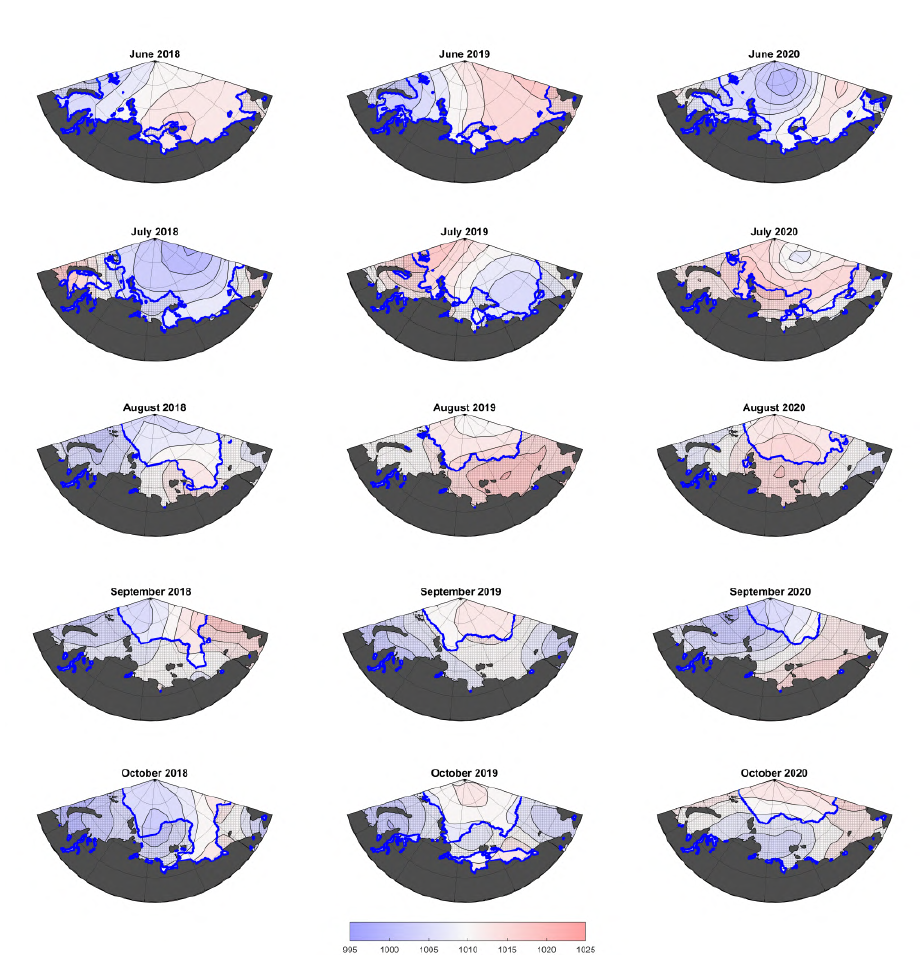
Figure 12. Ice edge position from June to October 2018–2020 from [12] (bold blue lines) and the corresponding NCEP/NCAR sea level pressure (hPa) distribution [42] (colors are according to colobar, extra shading represents ice-free area). Contour lines represent isobars from 995 to 1025 hPa with 2.5 hPa